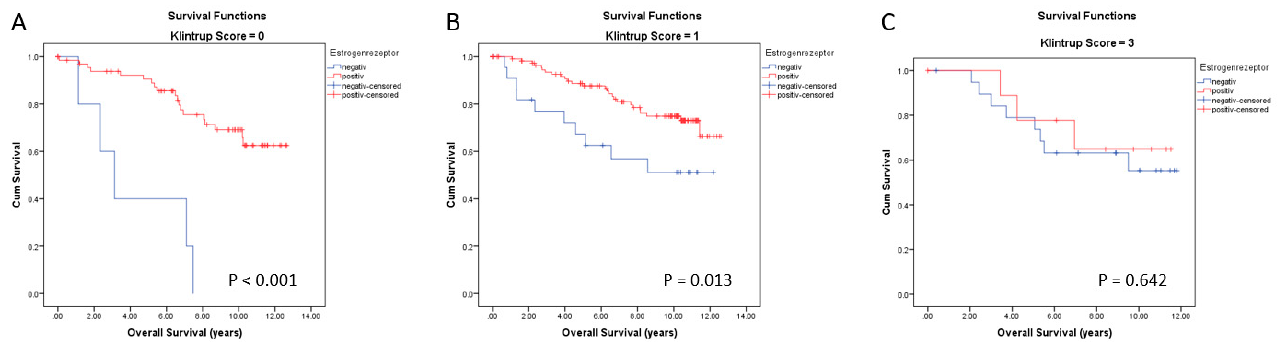
Figure 9. Kaplan–Meier survival analyses for estrogen receptor (ER α ) according to the level of peritumoral inflammation with no inflammatory cells at the invasive margin (Klintrup Score 0 ( A )), mild and pathy increase of inflammatory cells (Klintrup Score 1( B )) and increased inflammatory cells (Klintrup Score 2 ( C )) on overall survival